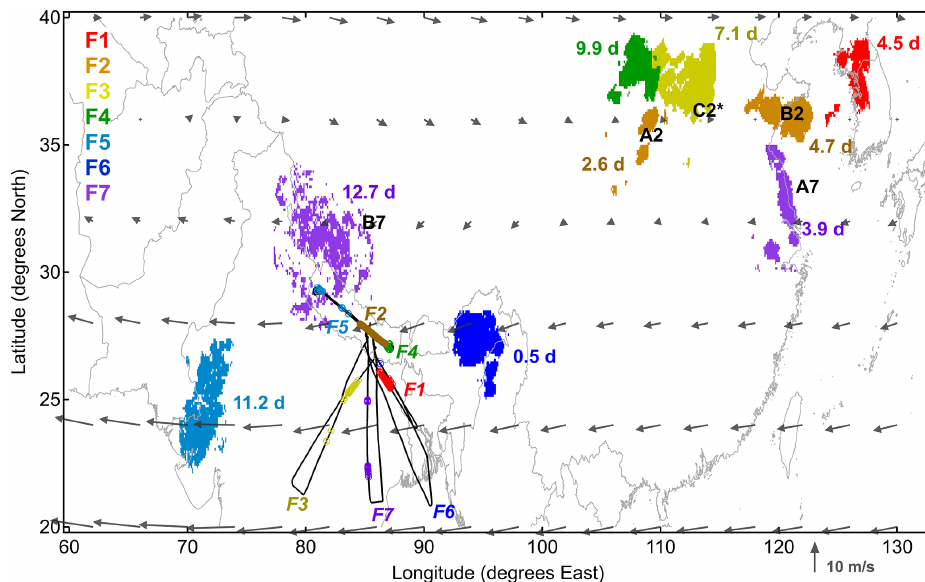
Figure 5. Composite map of convective clouds (highest cloud class) linked by back trajectories with the observed hydrated (wet-and-heavy) parcels. The colour of convective systems indicates the flight number (F x ; see legend) in which the respective parcels were sampled. The same colour code is used to mark the flight segments where these parcels were probed. The convective age (days) is indicated for each convective system. The convective sources for the features of interest in flight F2 (A2, B2, C2*) and F7 (A7, B7) are annotated (see Sect. 5). The arrows are wind velocity vectors (ERA5, 70–100hPa